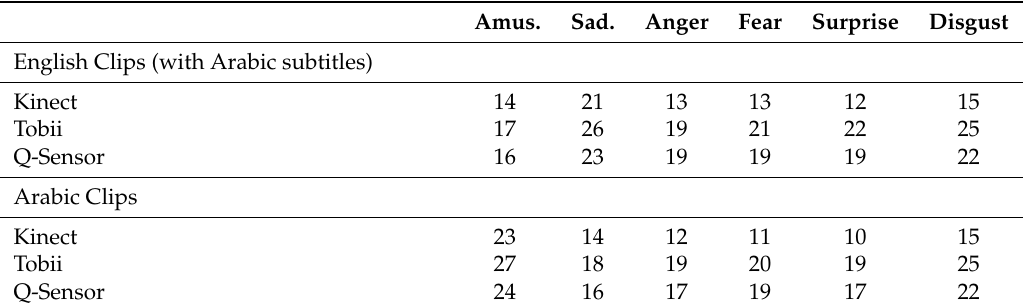
Table 5. Number of segments for each emotion and each device in the physiological and behavioural